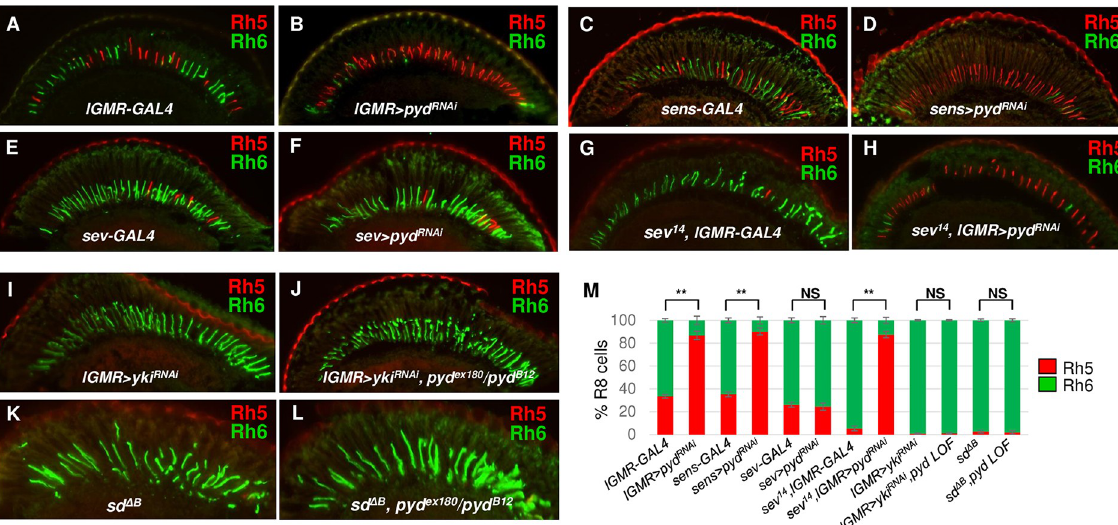
Fig 3. Pyd cell-autonomously specifies R8 subtypes. (A-F) Cryosections of adult eyes stained for Rh5 (red) and Rh6 (green) in control (A, C and E) and pyd knock-down flies. Pyd is knocked down in all PRs (B, lGMR > pyd RNAi - KK105581 ), in only R8s (D, sens > pyd RNAi-kk105581 ) or in R7s (F, sev > pyd RNAi-KK105581 ). (G-H) Cryosections of sev mutant eyes ( sev 14 ; lGMR-GAL4 ) (G) and sev; pyd double LOF eyes (H, sev 14 , lGMR > pyd RNAi - KK105581 ). (I-J) Cryosections of the yki knock-down ( lGMR > yki RNAi - KK109756 ) adult eyes in control (I) or in pyd loss of function